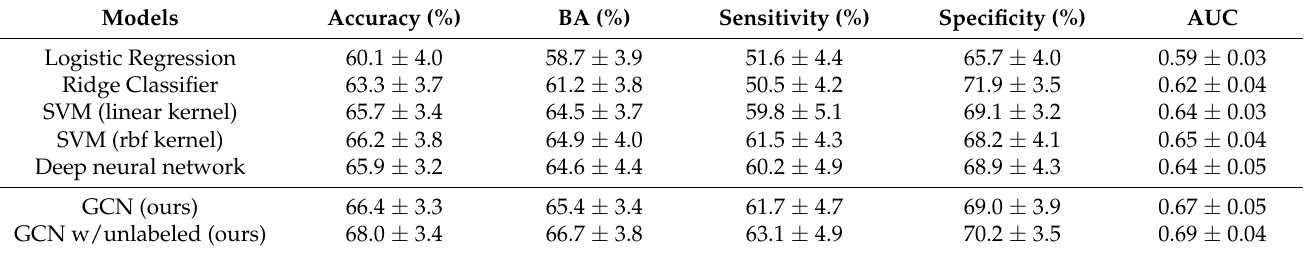
Table 2. Performance comparison for the prediction of very preterm infants at high risk vs. low risk of developing moderate/severe motor abnormalities at 2 years corrected